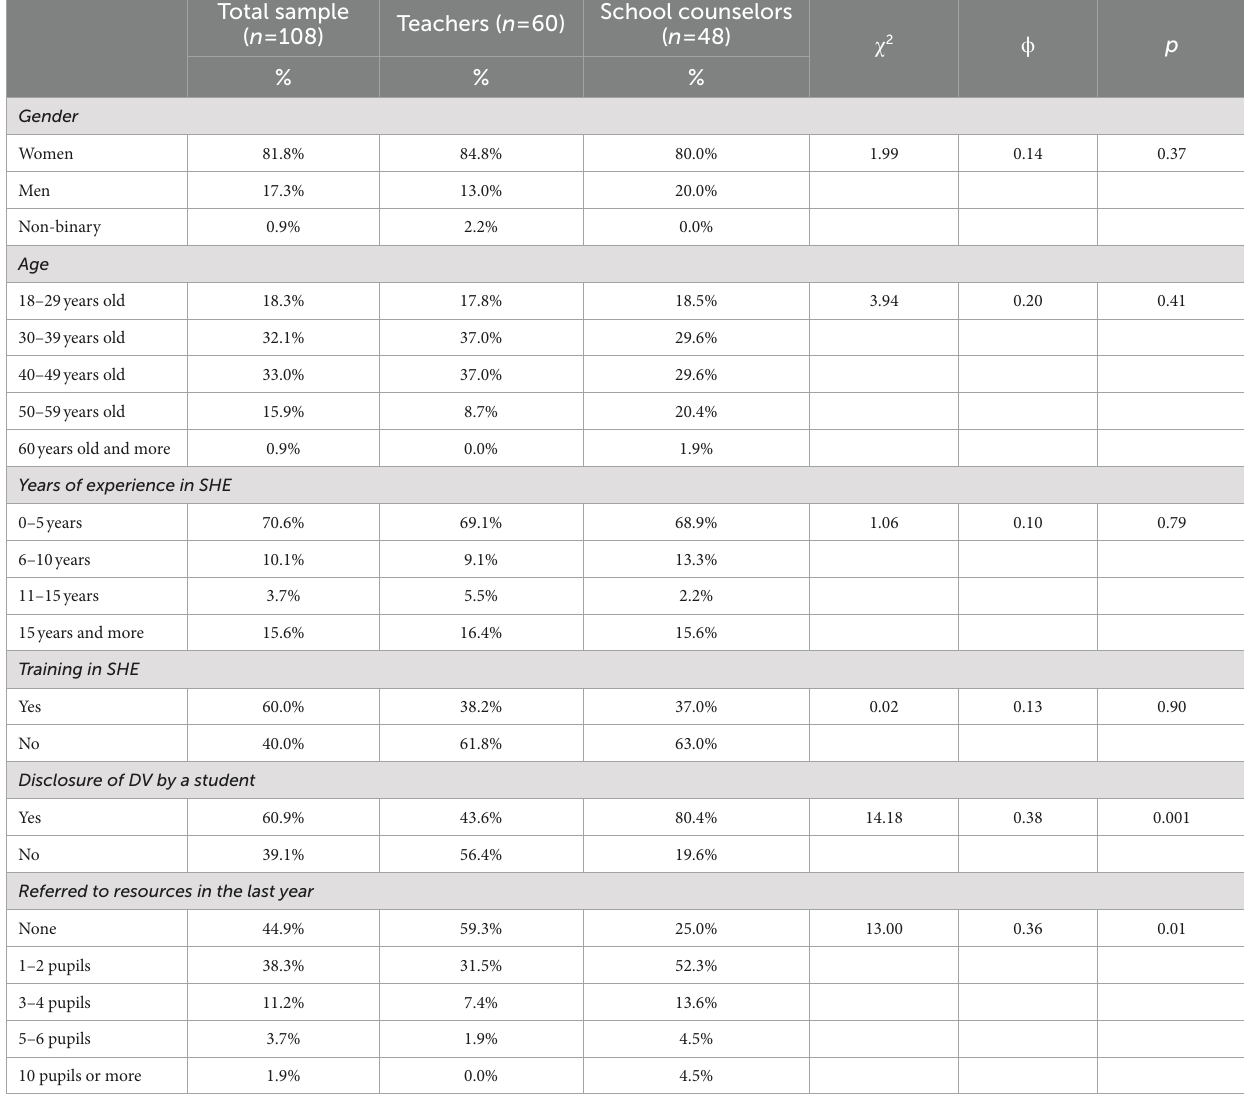
TABLE 1 Sociodemographic characteristics of the sample ( n =